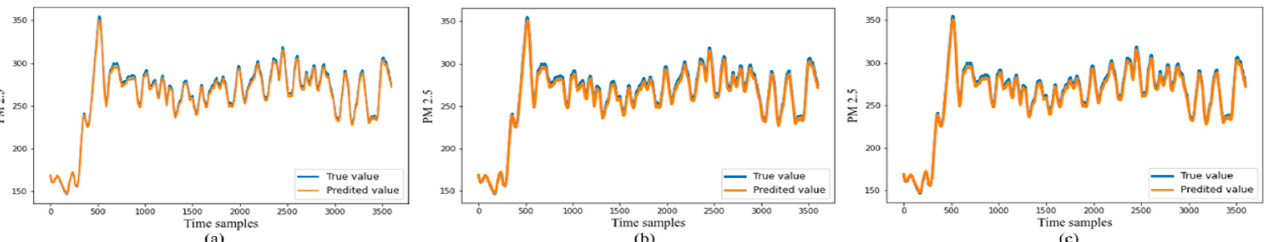
Figure 7. Comparison of true value and predicted value in 1 h ahead prediction for ( a ) 20 epochs, ( b ) 30 epochs, ( c ) 40 epochs.